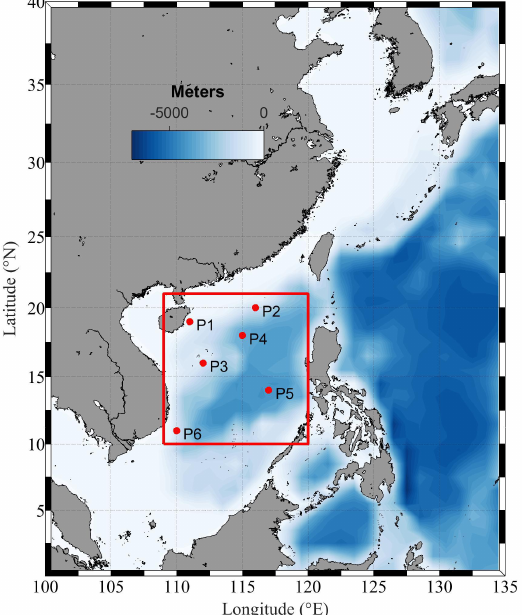
Figure 1. The geographic of the study area and six points as well as bathymetry, where the red square represents the study area and the six red dots indicate representative